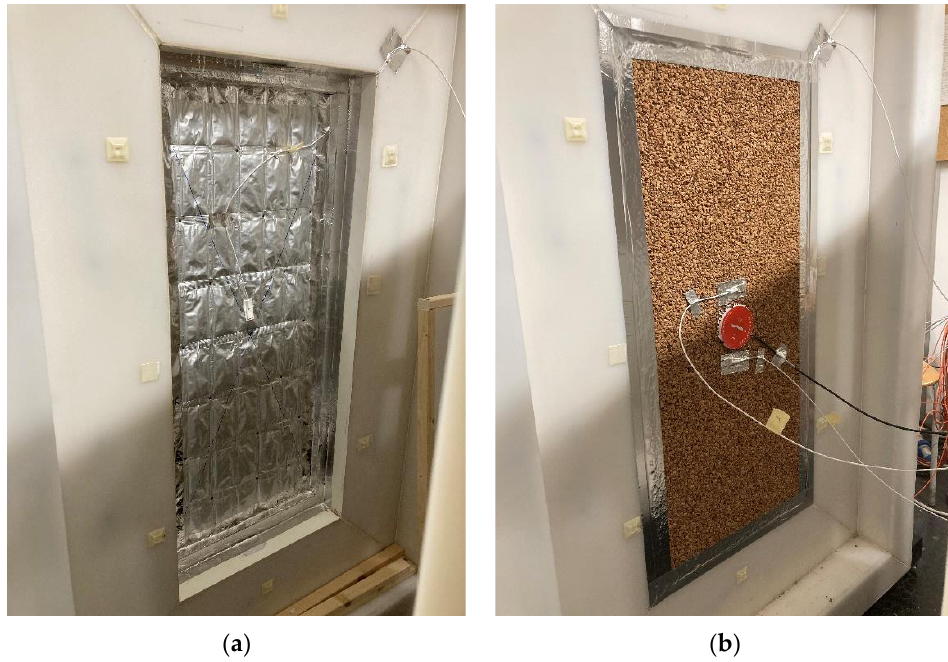
Figure 23. Details of the installation of the PCM sheet inside the SuberWall panel sample ( a ) and the probes used for the monitoring of the main thermal characteristics ( b ) by a climatic chamber.